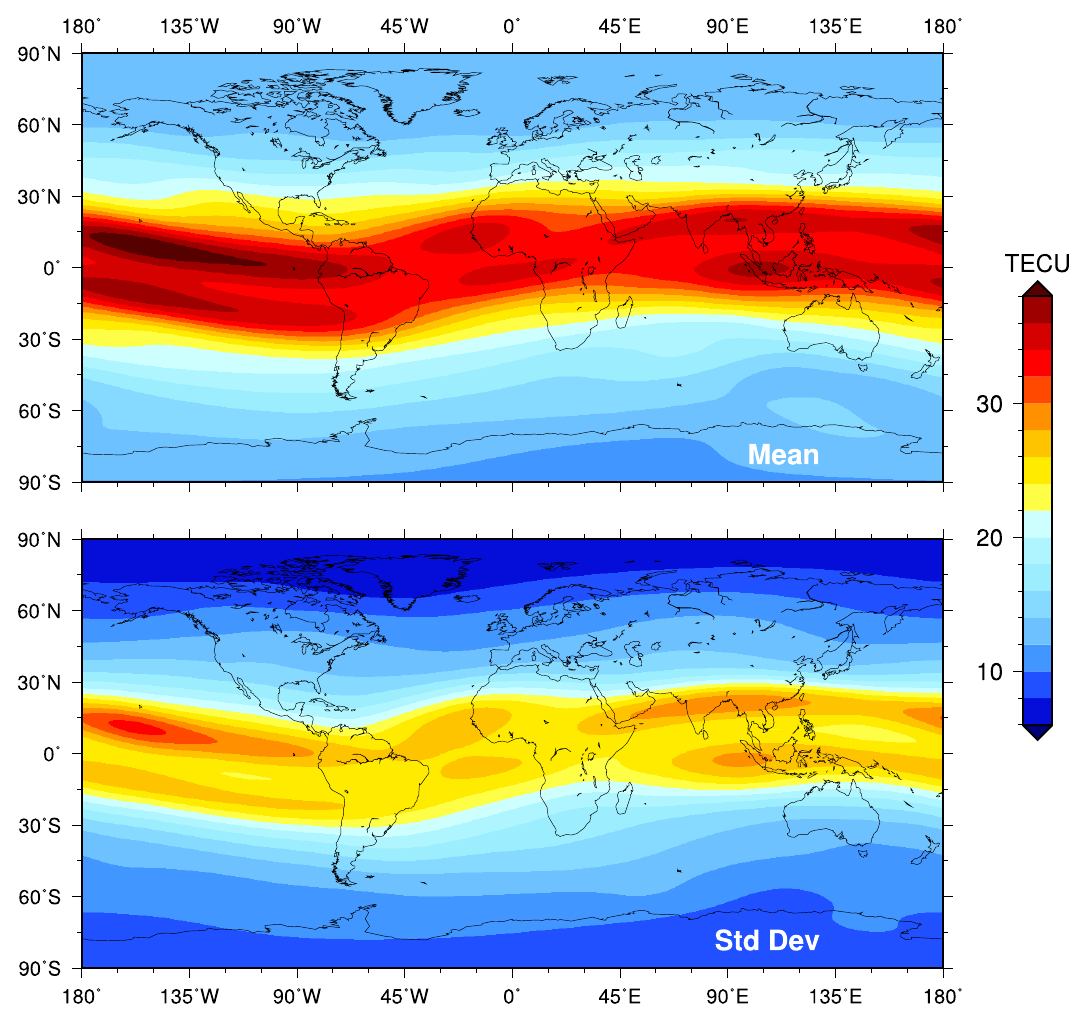
Figure 19. Mean ( top ) and standard deviation ( bottom ) of the Ku-band ionospheric